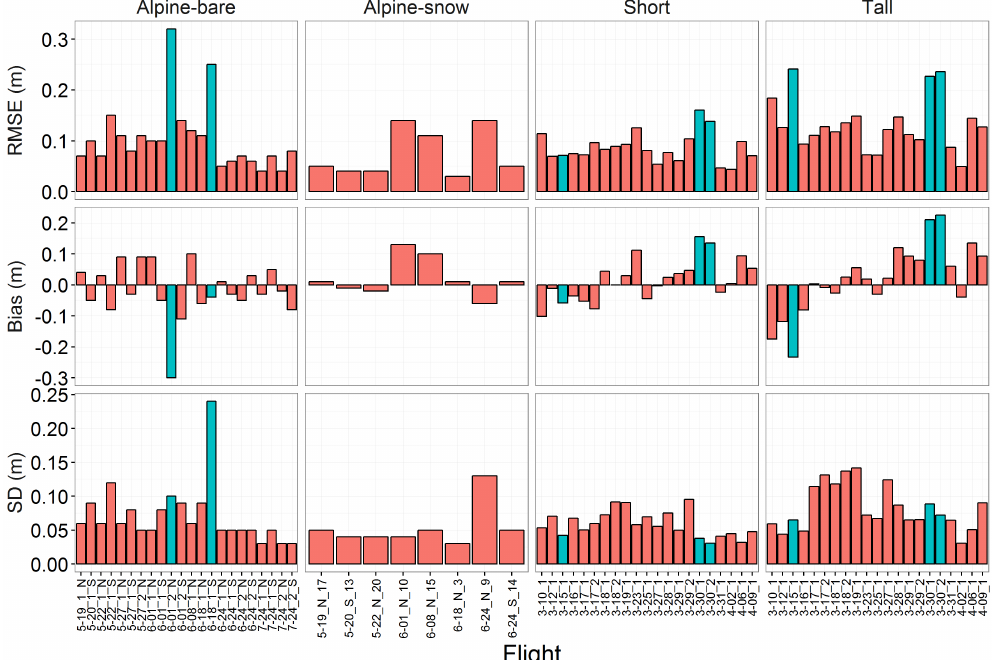
Figure 4. Root mean square error (RMSE, top row panels), bias (middle row panels) and standard deviation (SD, bottom row panels) of DSMs with respect to surface over alpine-bare, alpine-snow, and short and tall stubble at prairie site, respectively. Blue bars highlight problematic flights and are excluded from summarization in Table 2. The x axis labels represent month–day–flight number of the day (to separate flights that occurred on the same day). Alpine-bare accuracies are separated into northern or southern areas, reflected with an N or S suffix. The last number in the alpine-snow x axis label is the number of observations used to assess accuracy as the number of surface observations varied between 3 and